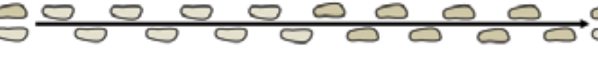
Figure 5-29. Line Jump Routine – Single Bunny Hop